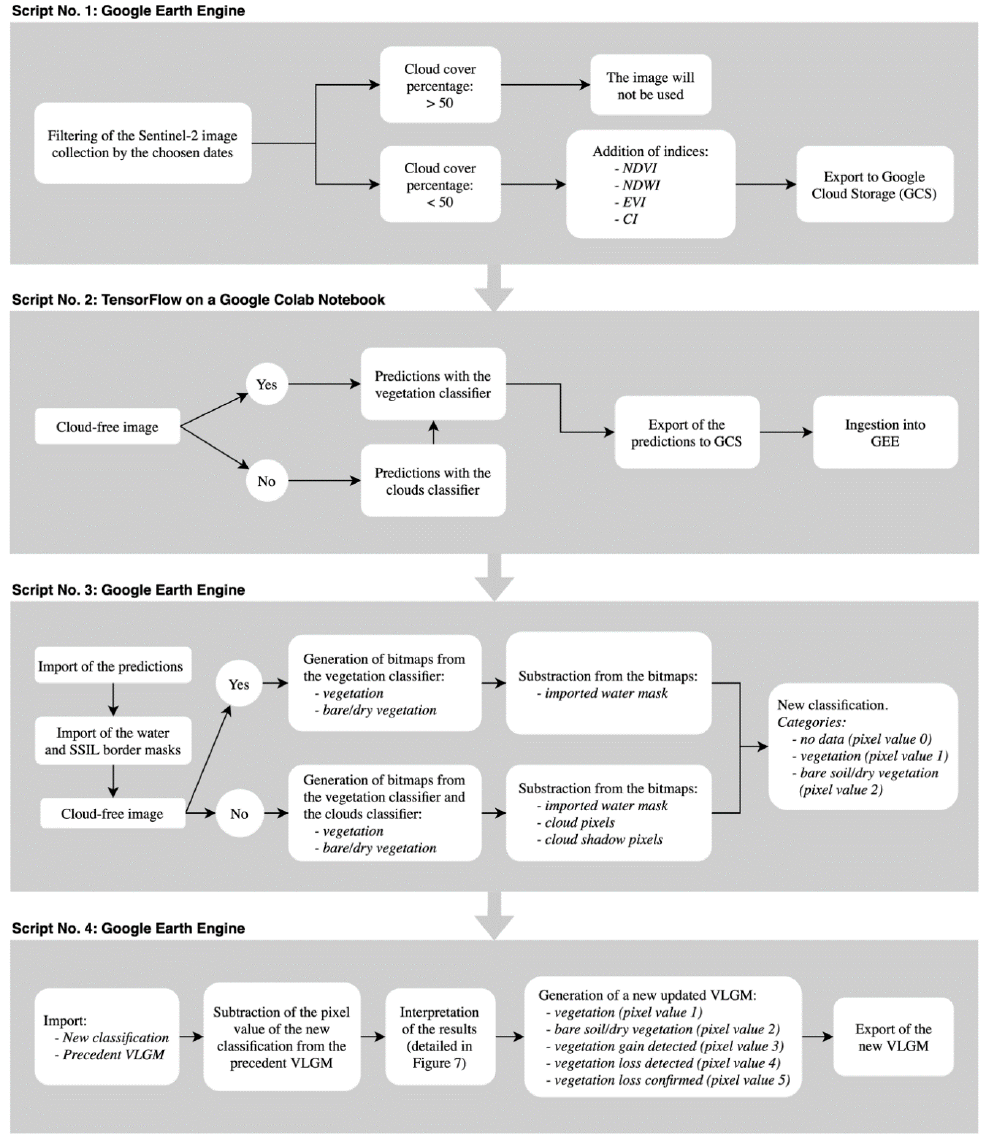
Figure 6. Workflow applied to a set of one year of data (5 September 2018 – 20 September 2019).